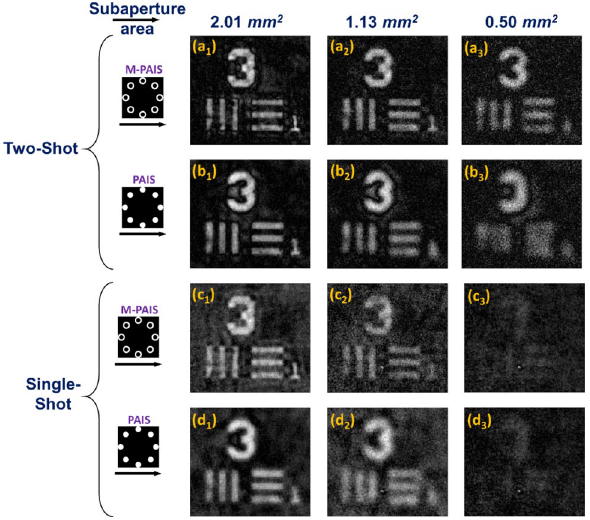
Figure 6. NLR results obtained from bipolar sparse holograms for, ( a 1 –a 3 ) M-PAIS with NLR coefficients o = 0.32, 0.56, 0.32 and p = 0.26, 0.24, 0.6; ( b 1 –b 3 ) PAIS with NLR coefficients o = 0.36, 0.2, 0.48 and p = 0.36,0.56, 0.32; NLR results of single camera shot of sparse hologram for ( c 1 –c 3 ) M-PAIS with NLR coefficients o = 0.24, 0.32, 0.44 and p = 0.48, 0.52, 0.28; ( d 1 – d 3 ) PAIS with NLR coefficients o = 0.28, 0.2, 0.28 and p = 0.4, 0.48, 0.44; subscript numbers represent images obtained from subaperture area of 2.01, 1.13 and 0.50 mm 2 .